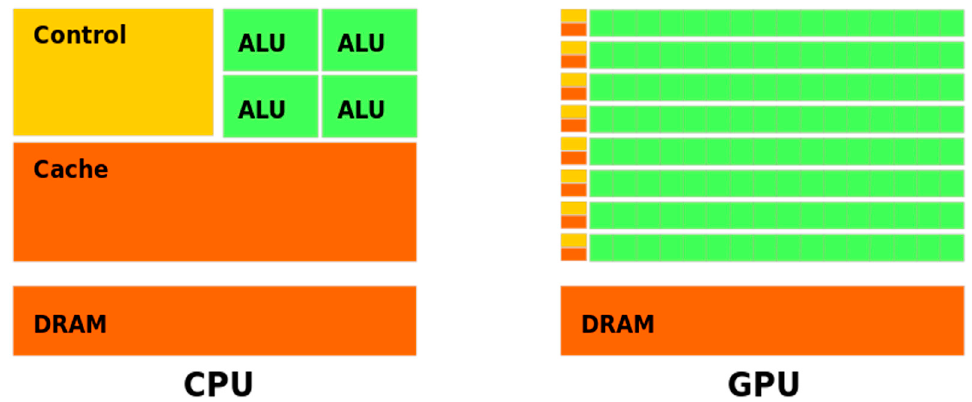
Figure 3. Illustration of the ratio of Control (yellow) and Cache (orange) to Arithmetic Logic Units (green) for a GPU ( left ) and a CPU ( right ) system.